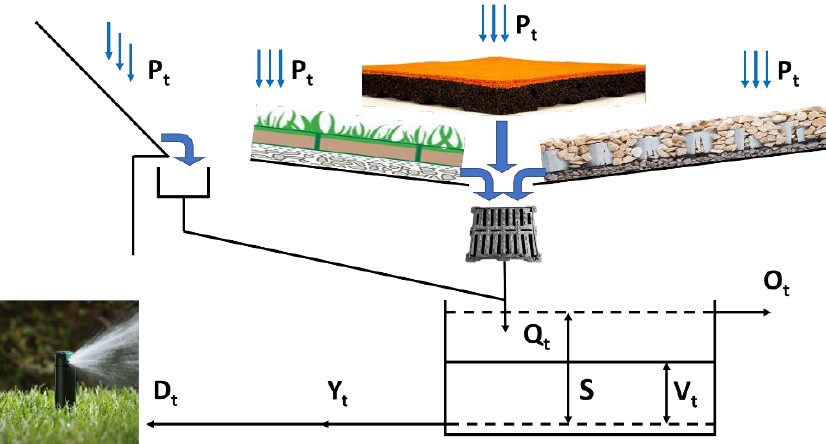
Figure 2. Schematics of the main elements of the simulated RWH system. P t is the precipitation amount; Q t is the rainwater inflow to the storage tank; S is the storage capacity of the system; V t is the rainwater volume stored in the tank; Y t is the released volume; O t is the overflow volume; and D t is the water demand.